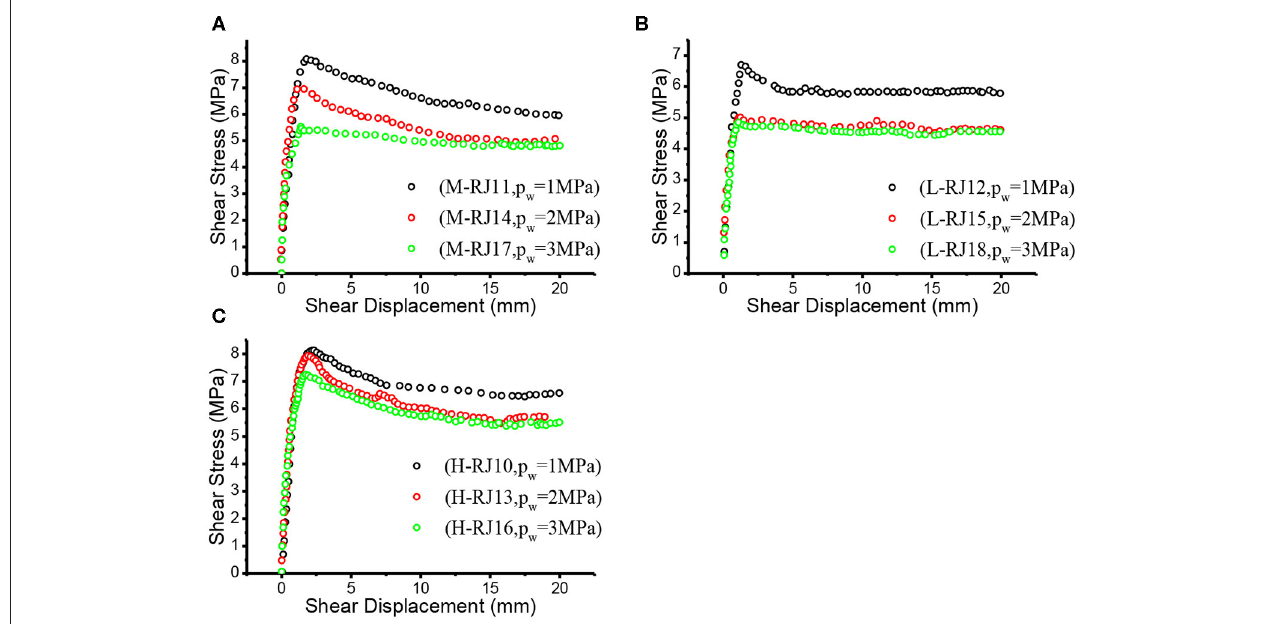
FIGURE 2 | Shear stress-displacement curves of three joint groups under normal stress of 8 MPa and three different seepage pressures. (A) M joint (B) L joint (C) H joint.